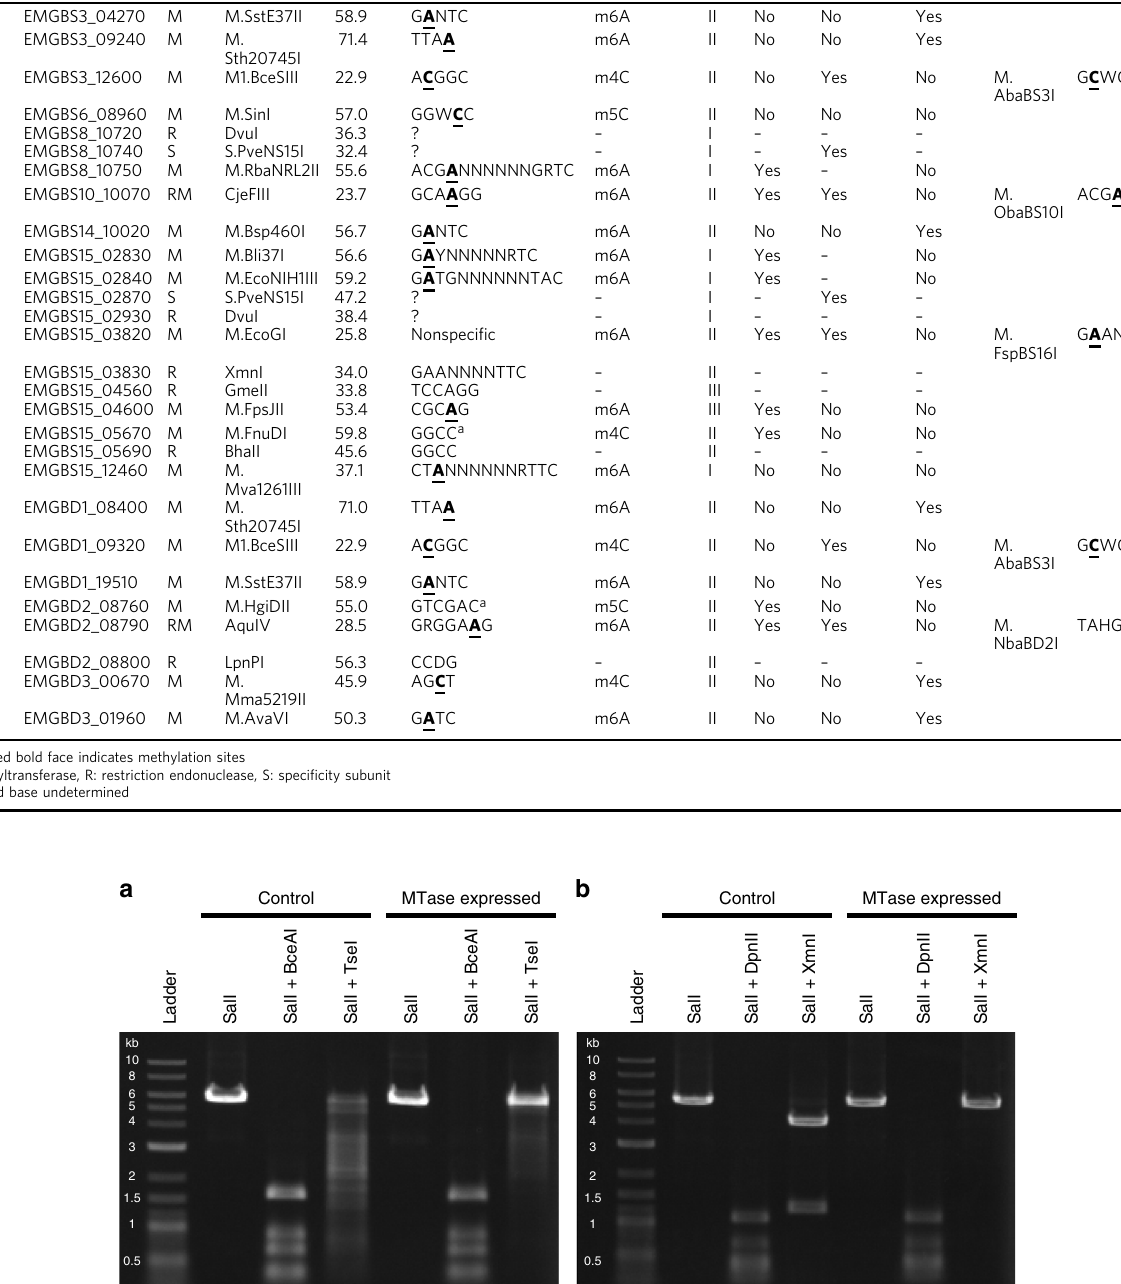
Table 4 Detected MTases, REases, and speci fi city subunit genes Genome CDS ID Gene Top-hit ID type protein in